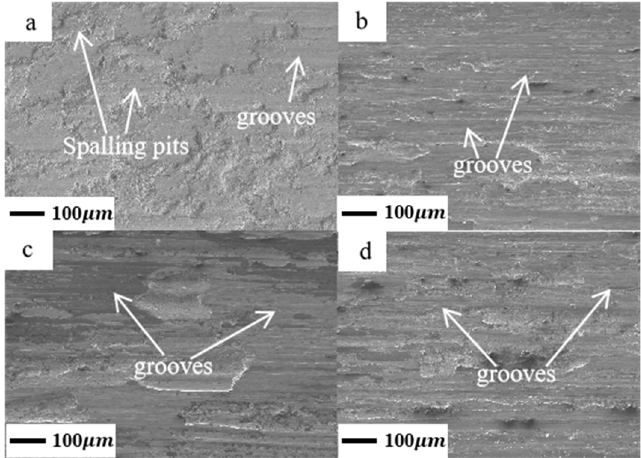
Figure 13. The wear profile of the test specimens ( a ) BM, ( b ) C80, ( c ) C100, ( d ) C120.